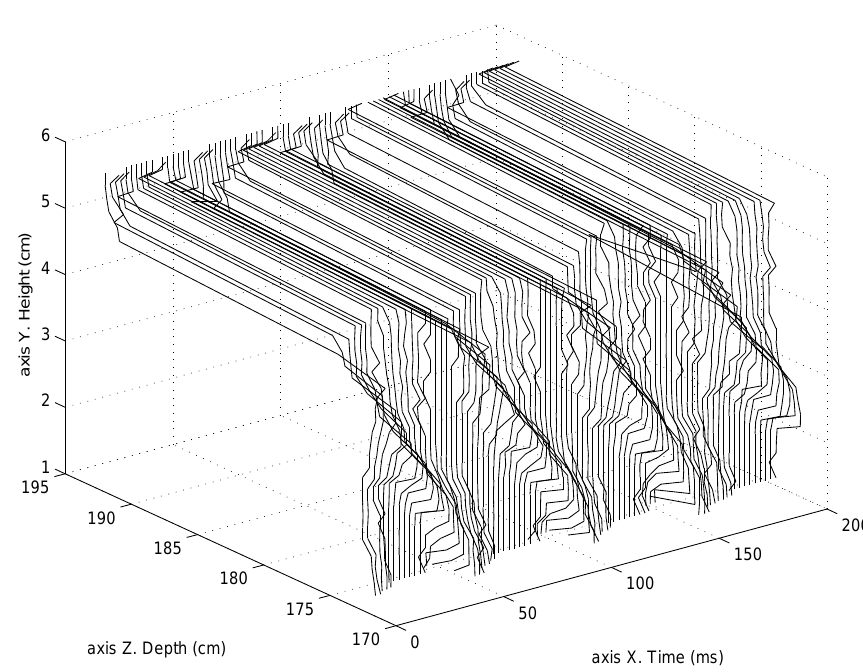
Figure 7. Rotating helix 2D reconstruction as a function of